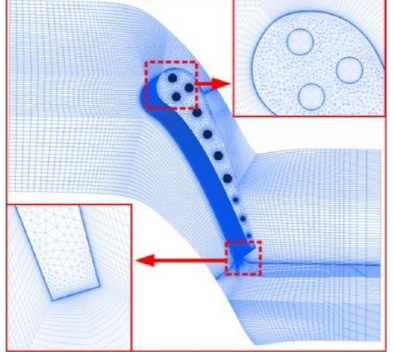
Figure 6. Computational grids of Mark II for low-Re turbulence